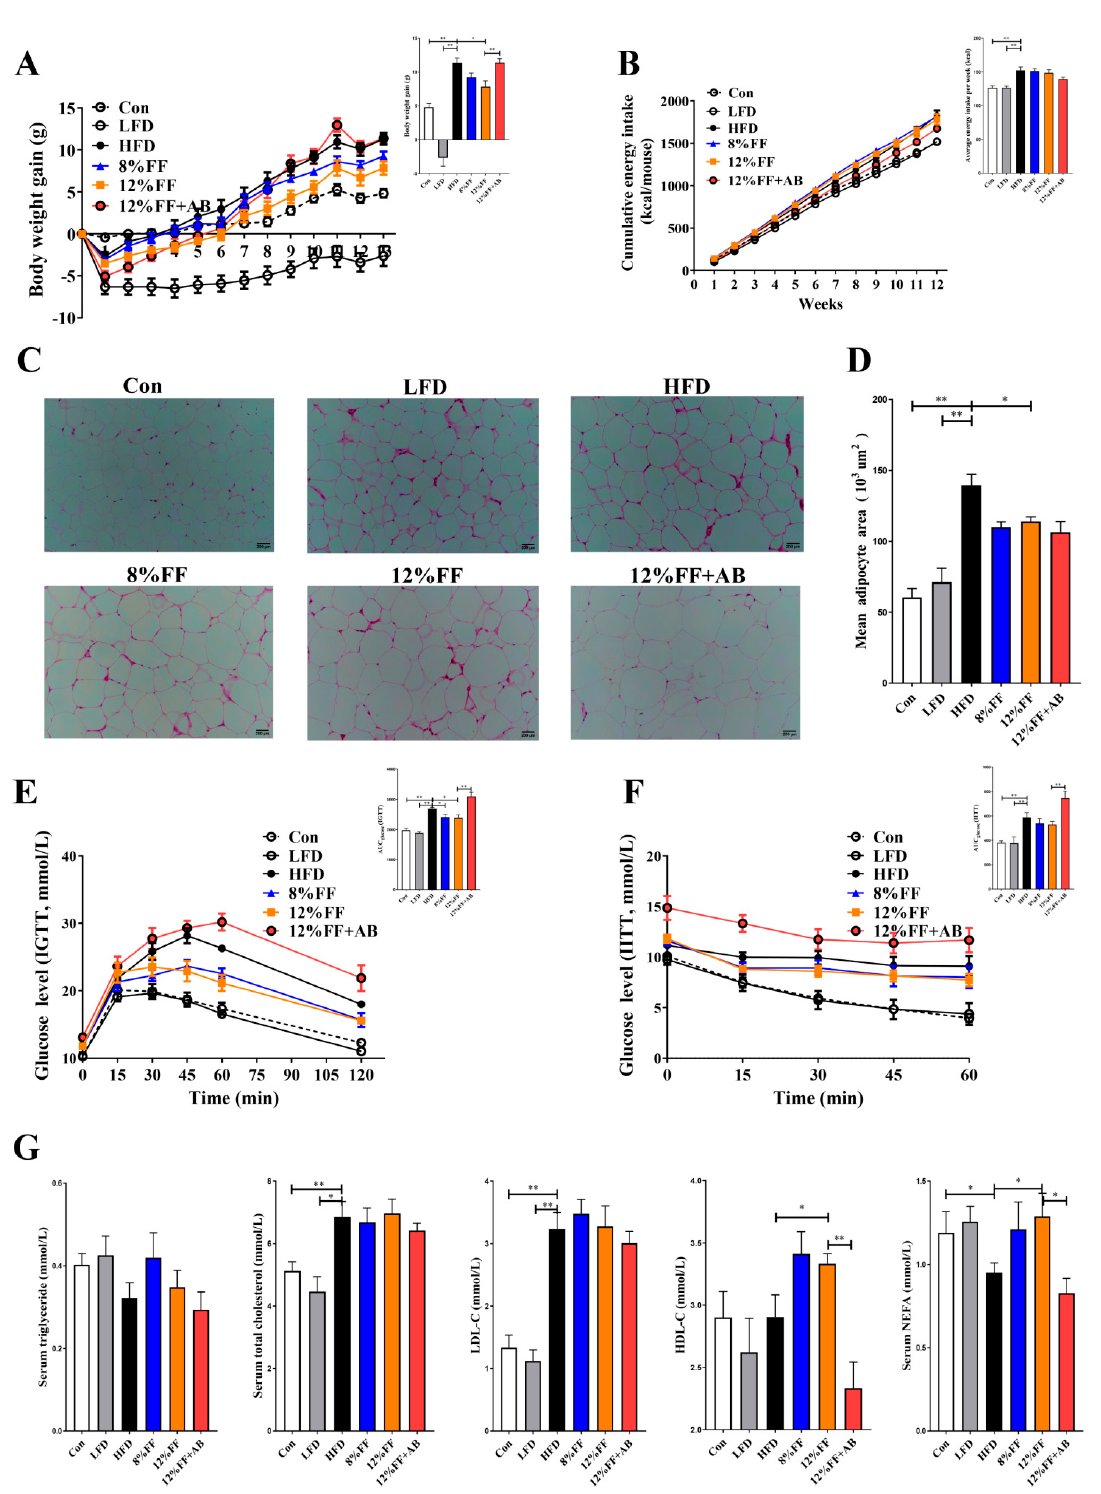
Figure 1. Effects of functional fiber (FF) on body weight, adipose tissue, and insulin sensitivity in diet-induced obese (DIO) mice ( n = 7). ( A ) Body weight over time and final body weight. ( B ) Accumulative energy intake and average energy intake per week. ( C ) H&E-stained section of epididymal adipose tissue. ( D ) The average area of epididymal adipose tissue cells. ( E ) Intraperitoneal glucose tolerance test (IGTT) and the area under the curve (AUC). ( F ) Intraperitoneal insulin tolerance test and the AUC. ( G ) The concentration of triglycerides, total cholesterol, low-density lipoprotein-cholesterol (LDL-C), high-density lipoprotein-cholesterol (HDL-C), and nonesterified free fatty acids (NEFA)